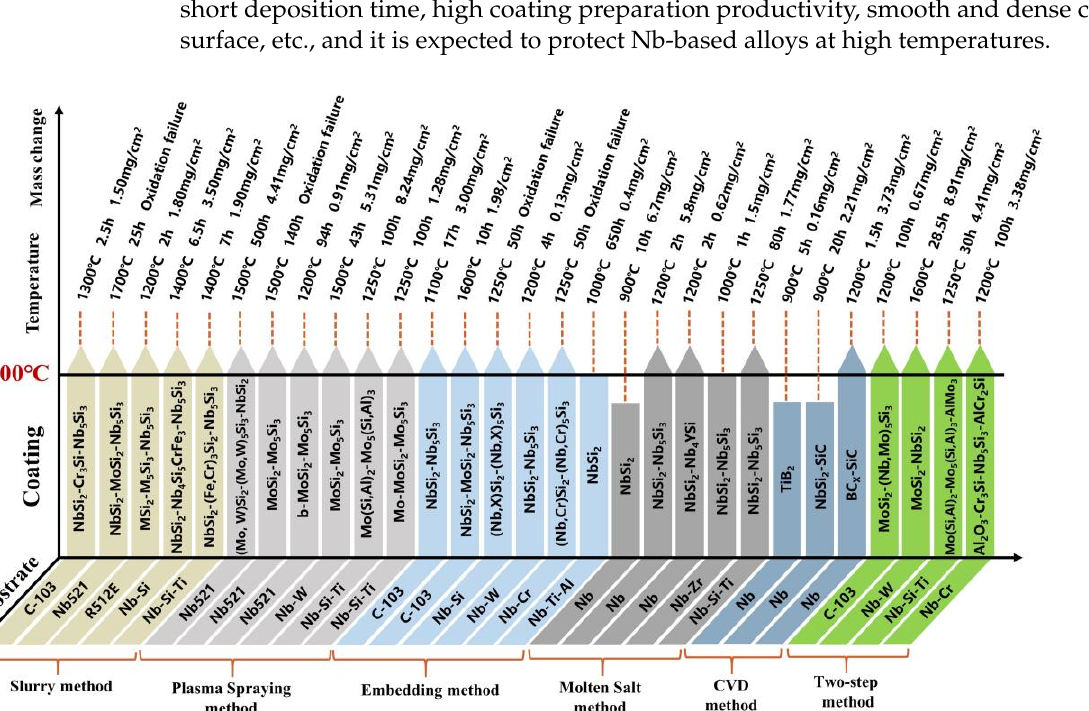
Figure 13. Overview of preparation parameters and oxidation resistance of Nb-based alloys surface coatings.